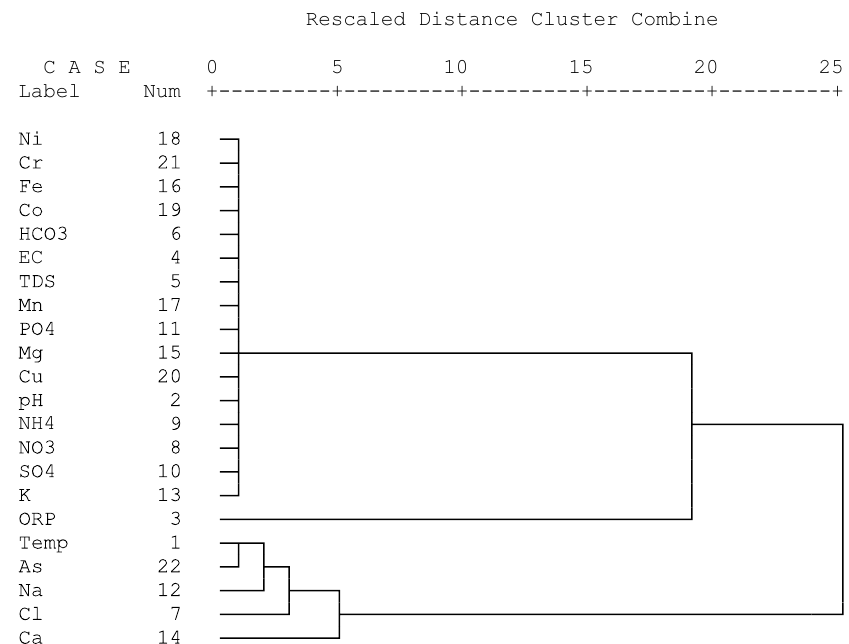
Dendrogram using Ward